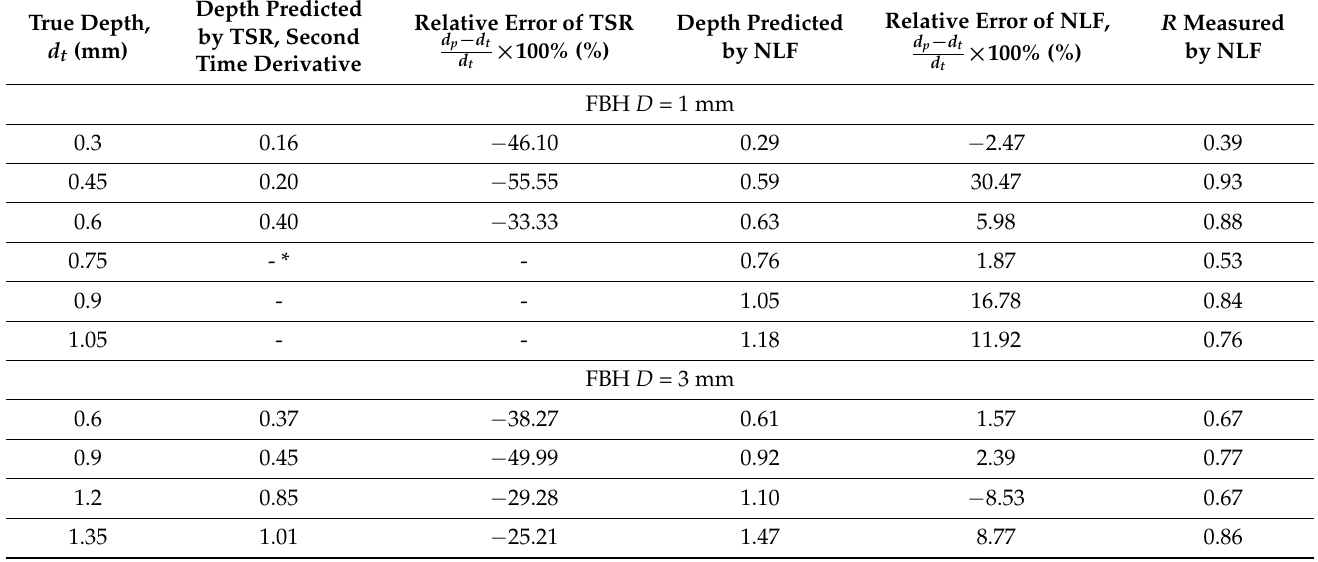
Table A2. Mean relative error of depth estimation by using TSR and NLF techniques